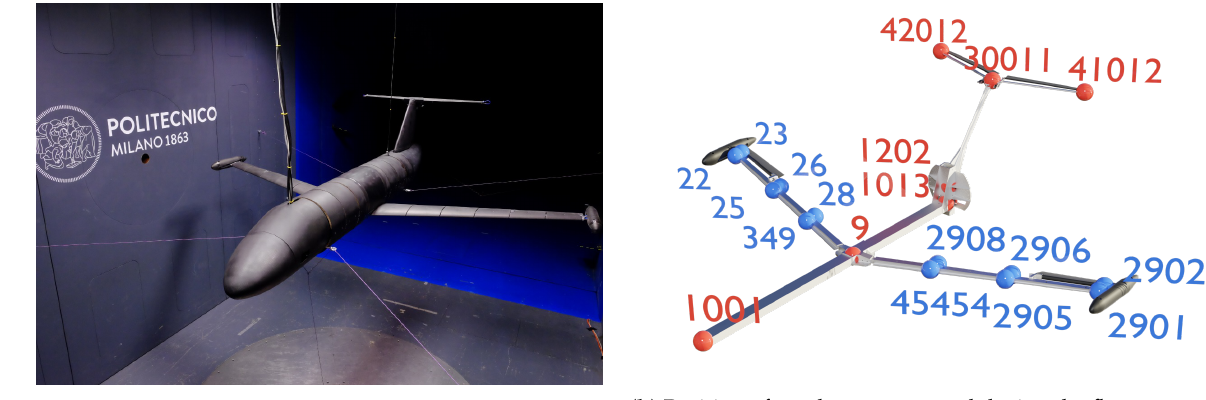
Figure 7. Wind tunnel test